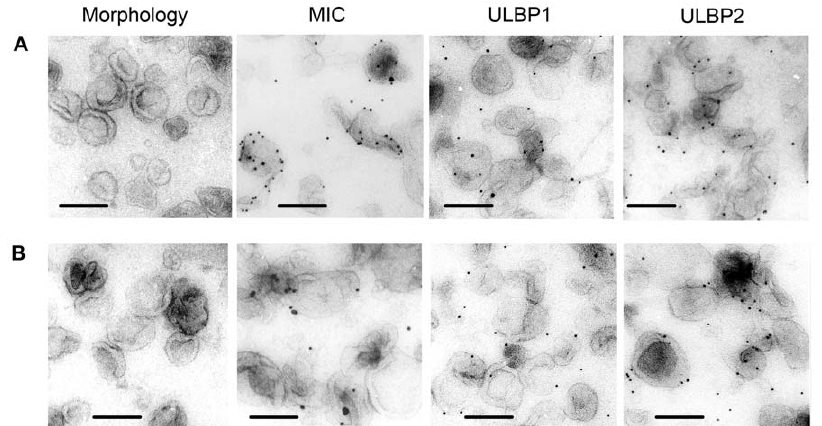
Figure 2. Electron microscopy analyses of secreted exosomes by Jurkat and Raji cells. Negative contrast staining showing typical exosomal morphology and electron micrographs illustrating immunogold staining of the NKG2D ligands MIC, ULBP1 and 2 of exosomes isolated from A. Jurkat and B. Raji. Bars represent 100 nm.